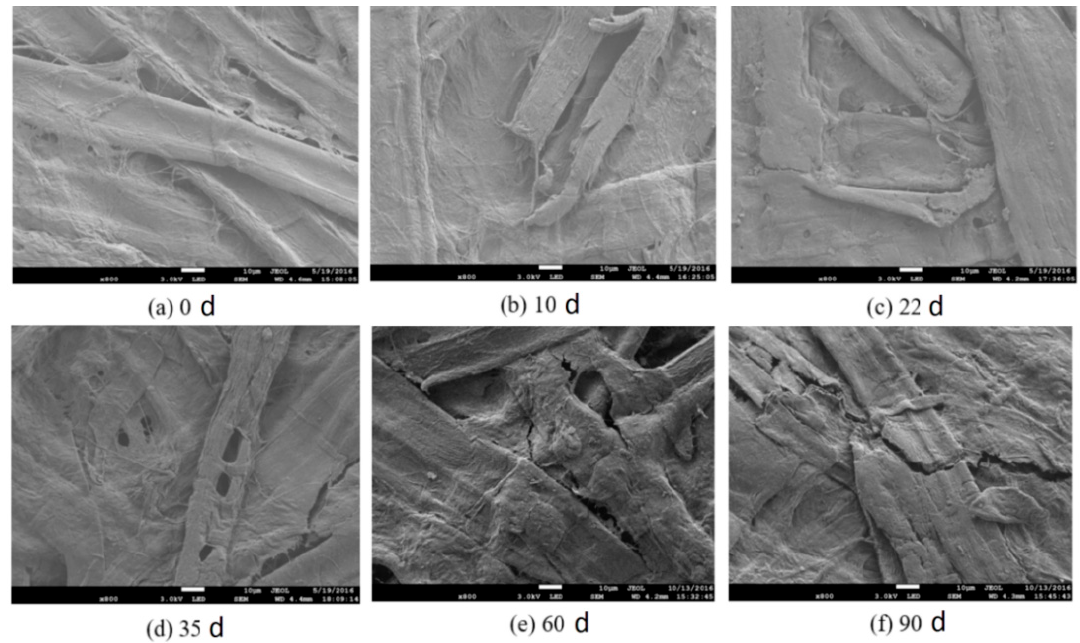
Figure 3. Fiber morphology at different aging times.